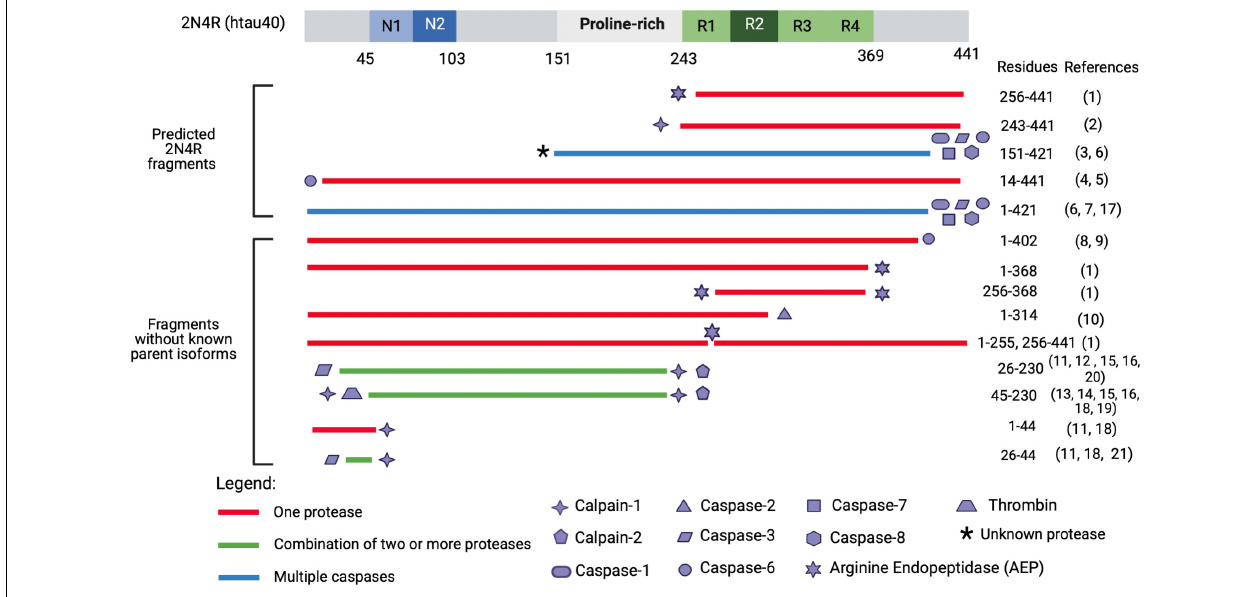
FIGURE 4 | Tau fragments found in in vitro and in vivo models with pathogenic functions and processing proteases. This figure illustrates a select group of tau proteolytic fragments which have been shown to have to drive neurotoxicity in either in vitro or in vivo models (correlated with Tables 1 , 2 ) and have a known responsible protease. Precipitating proteases are represented by shape symbols and tau fragments are colored coded based on whether they are cleaved by one or multiple proteases. The top fragments are hypothesized to derive from 2N4R isoform as they extend past aa 410, which is the termination point of the second largest tau isoform, 2N3R. Several fragments from Gu et al. (2020) including tau 51–391, tau 51–421, tau 51–441, tau 151–391, tau 231–391, tau 231–421, and tau 231–441 are not included as they were engineered through recombinant plasmid techniques and have not been identified endogenously. Tau 187–441 and tau 1–391 are excluded as it is unclear which proteases cleaves at G186-E187. Tau 1–156 is excluded as it is unclear if thrombin, which cleaves at R155-G156 (Arai et al., 2005) also cleaves at G156-A157. The * symbol indicates that it is unknown what protease cleaves at the N-terminus of tau 151-421. Tau proteolytic fragments have not been studied to precipitate in up-regulated concentrations from 3R- or 4R-isoforms, and it is unclear whether 3R- or 4R-isoforms more toxic fragments. Reference numbers in parentheses refer to cited articles as follows: (1) Zhang et al. (2014); (2) Matsumoto et al. (2015); (3) Ozcelik et al. (2016); (4) Horowitz et al. (2004); (5) Horowitz et al. (2004); (6) Gamblin et al. (2003); (7) Quintanilla et al. (2009); (8) Foveau et al. (2016); (9) Guo et al. (2004); (10) Zhao et al. (2016); (11) Amadoro et al. (2006); (12) Amadoro et al. (2012); (13) Lang et al. (2014); (14) Afreen et al. (2017); (15) Park and Ferreira (2005); (16) Garg et al.